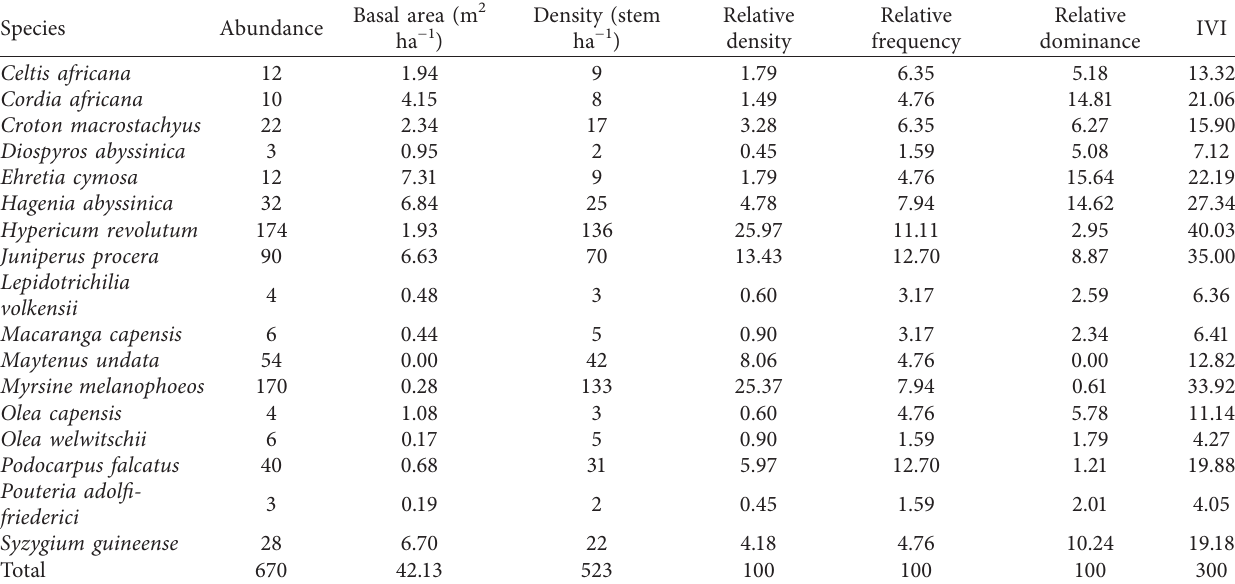
Figure 2: Box plot showing woody species density (a) and basal area (b) in the habitats. Table 4: Woody species structure in the edge habitats of the